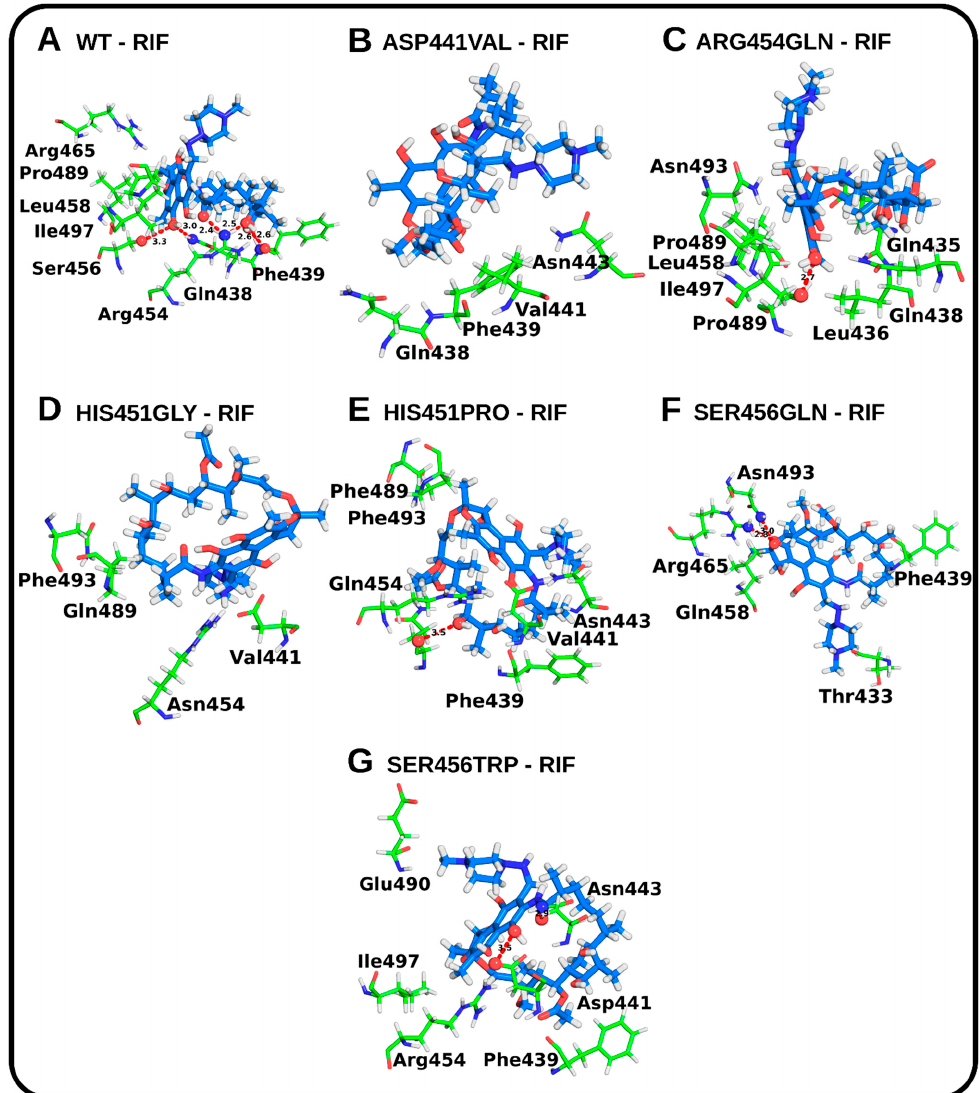
Figure 2. Post-docking analysis: The three-dimensional illustration of molecular interactions of RIF with the WT and mutated forms of M. tuberculosis rpoB . RIF is shown as blue sticks colored by heteroatom. Interacting atoms and associated residues are shown as spheres and sticks (colored green), respectively. Hydrogen bonds are shown as dashed red lines.